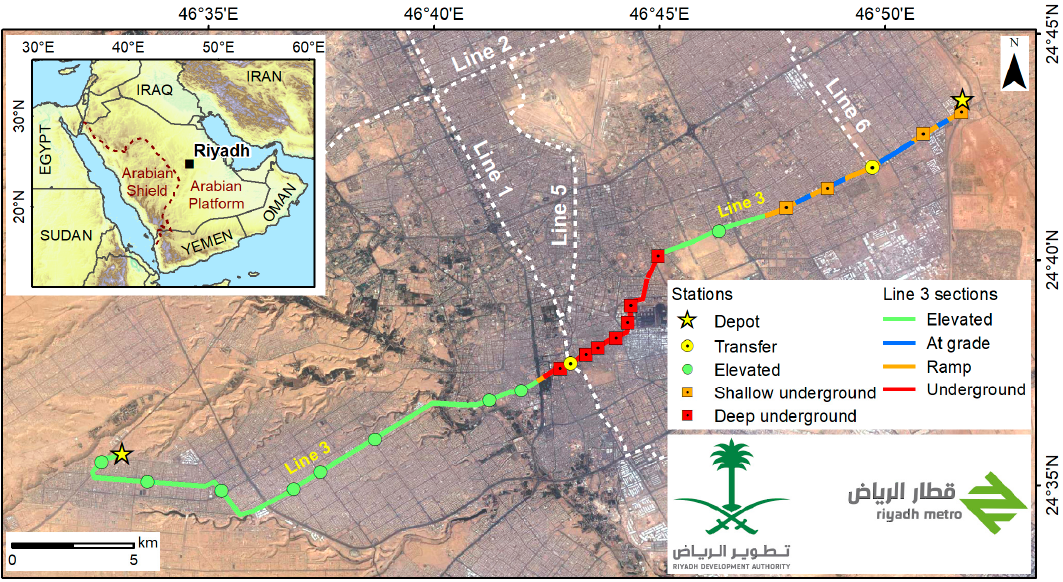
Figure 2. Riyadh Metro Project layout showing the different types of sections and stations with different colors depending on their type along the Line 3